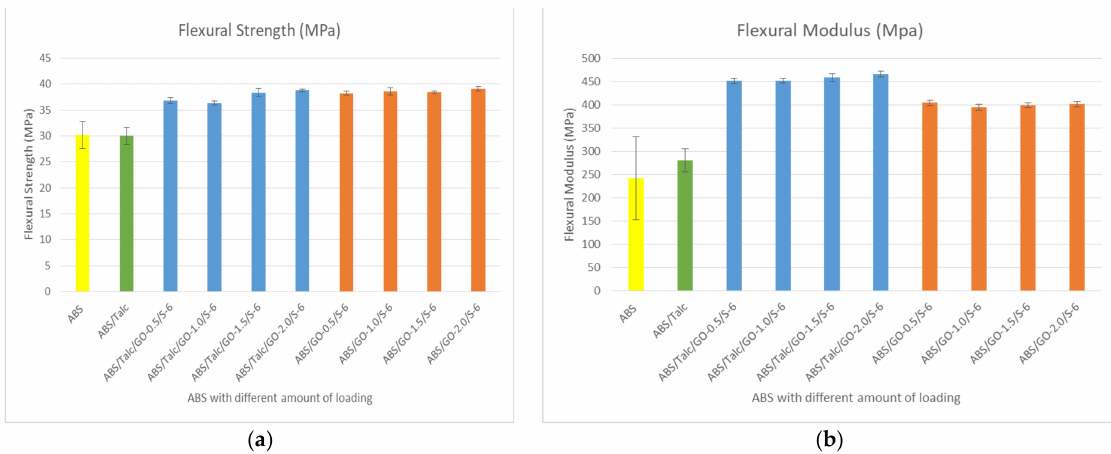
Figure 6. ( a ) Flexural strength and ( b ) flexural modulus of ABS and ABS/talc, with different loading of